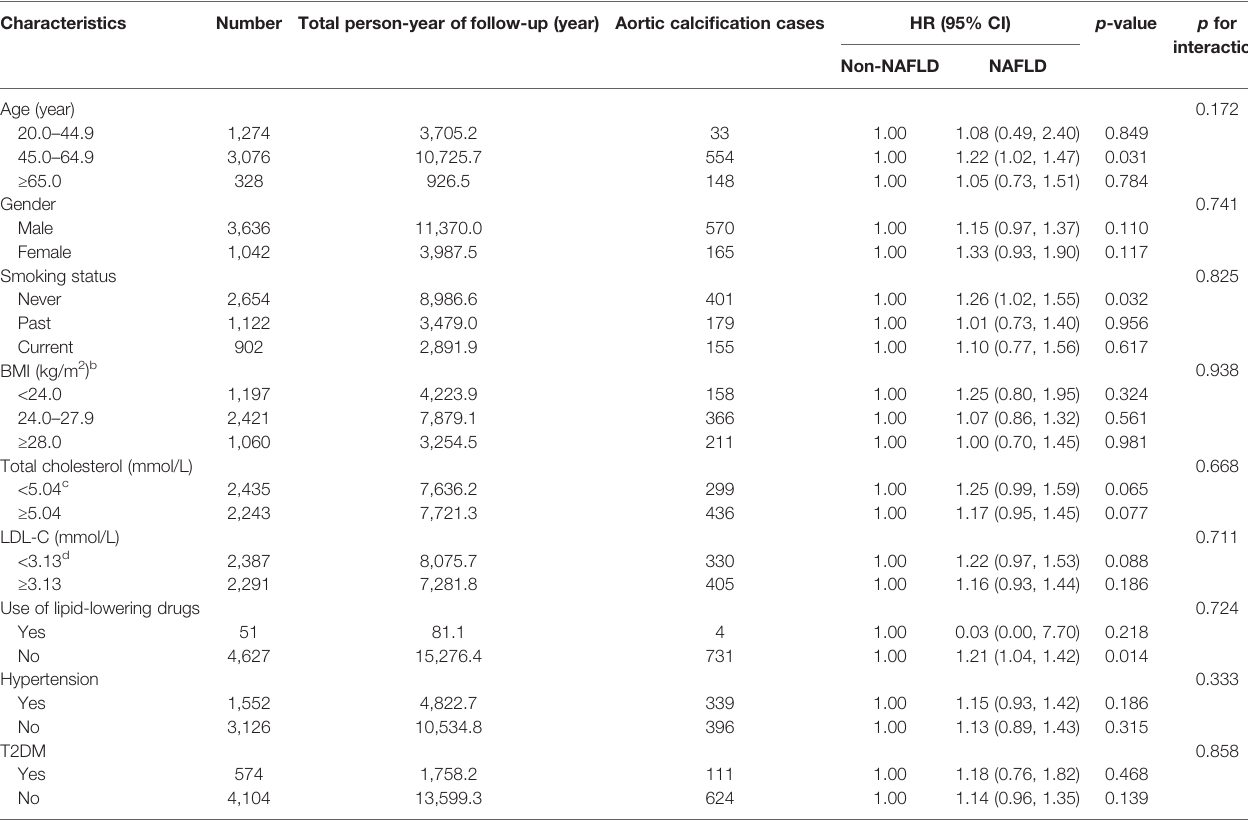
TABLE 3 | Subgroup analyses of variables in relation to non-alcoholic fatty liver disease with the incidence of aortic calci fi cation after propensity score matching a .